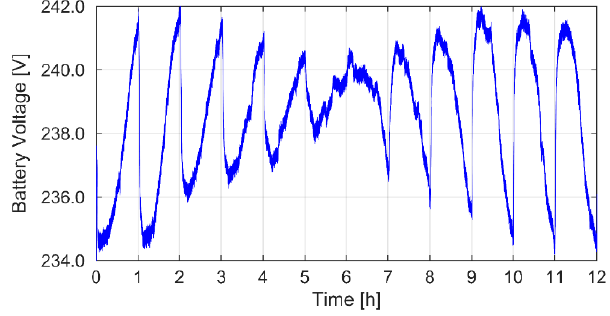
Figure 8. Battery voltage waveform.